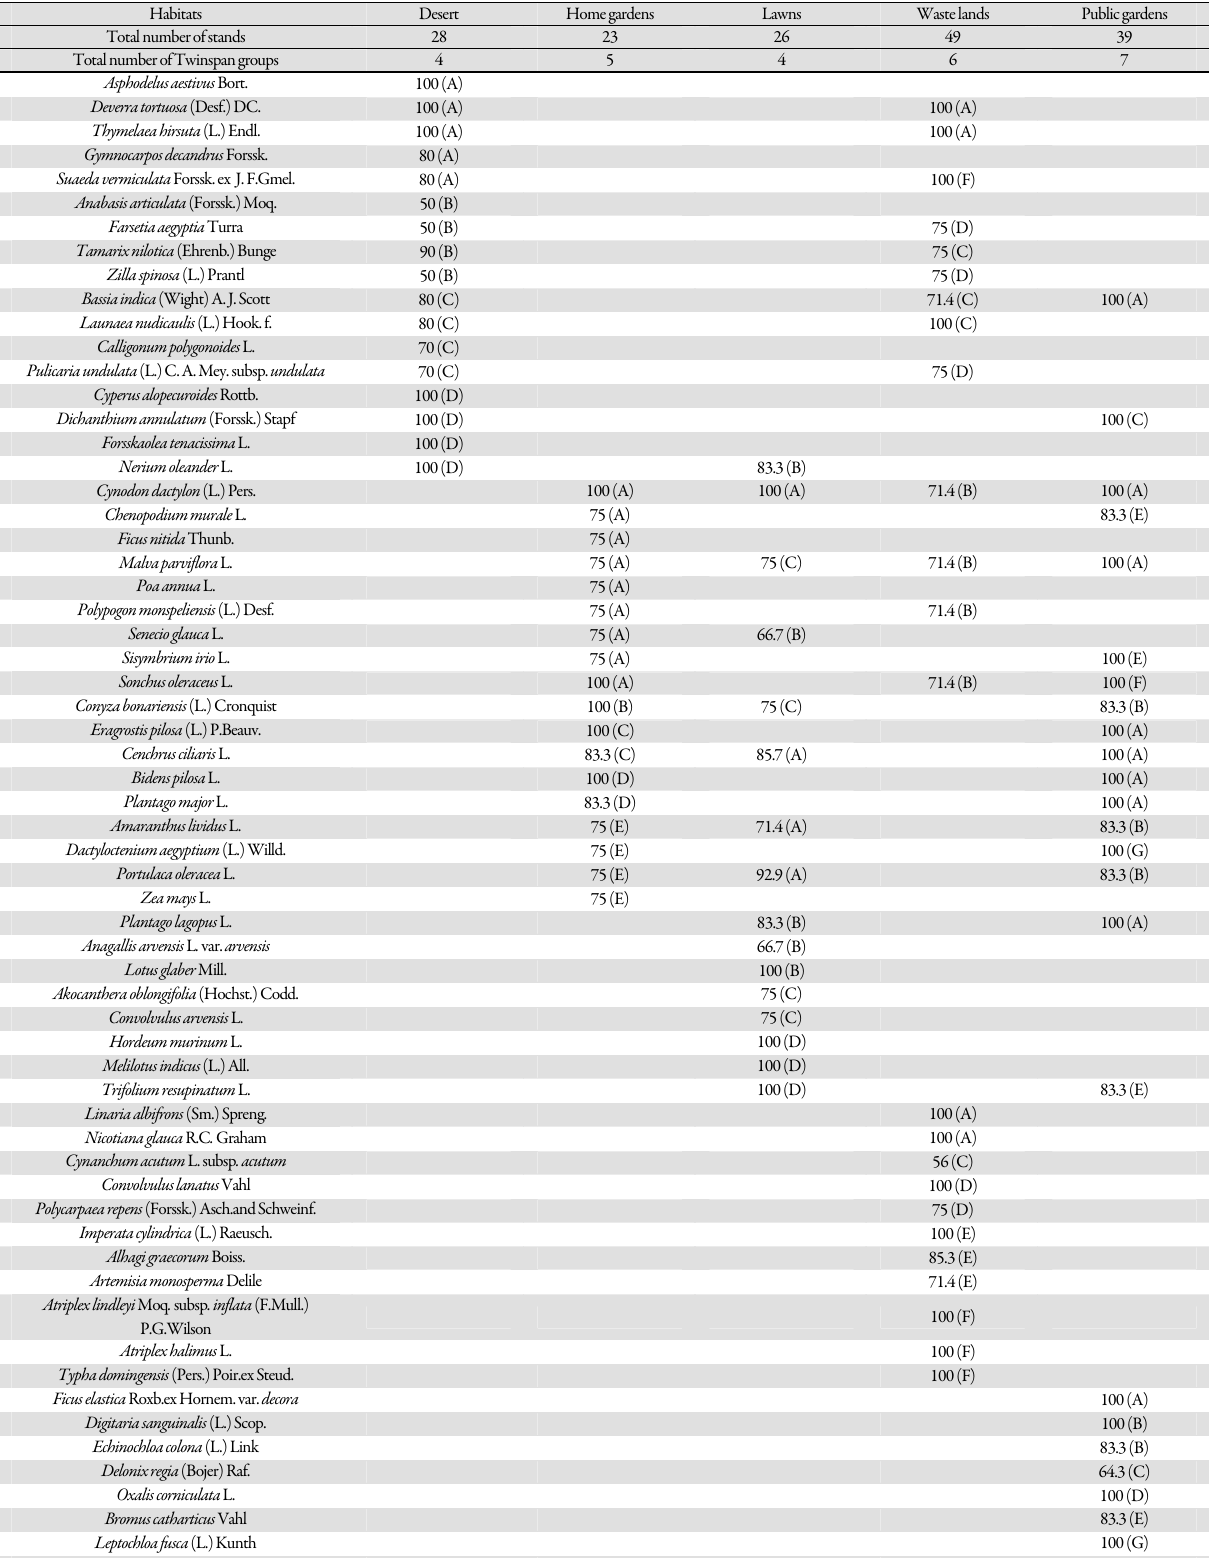
Table 2 . Characteristic species of Twinspan classification for each of the urban habitats studied. Letters between parentheses are the Twinspan vegetation groups, figures are the highest presence percentage of each species in the habitats’ vegetation